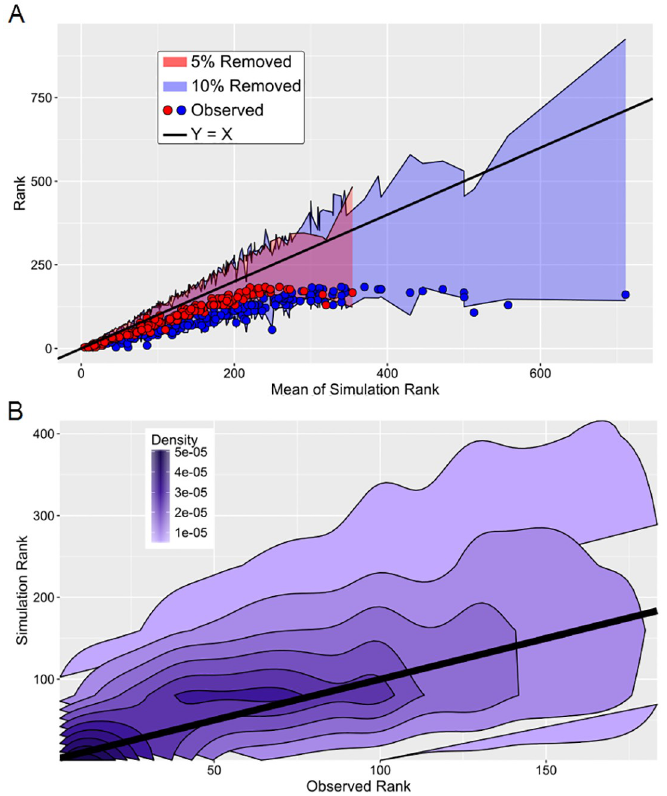
Fig 5. Robustness of single threshold methods and NEEP. (A) The central 50 ranks for the 100 simulations of each of the 181 significant splice variants are plotted as a shaded range according to their mean simulated rank, separately for the 5% simulations (red) and the 10% simulations. Each of these ranges correspond to an observed (non-simulated) rank, which is plotted as a dot along the same x-axis. The 5% simulation ranges have lower means of simulation rank than the 10% simulation ranges; thus the red dots are closer to the identity line. The maximum mean of the simulation rank is lower for the 5% simulations; thus the red shade ends much sooner than the blue shade. (B) The density plot of the observed vs. simulation pairs for the 181 significant splice